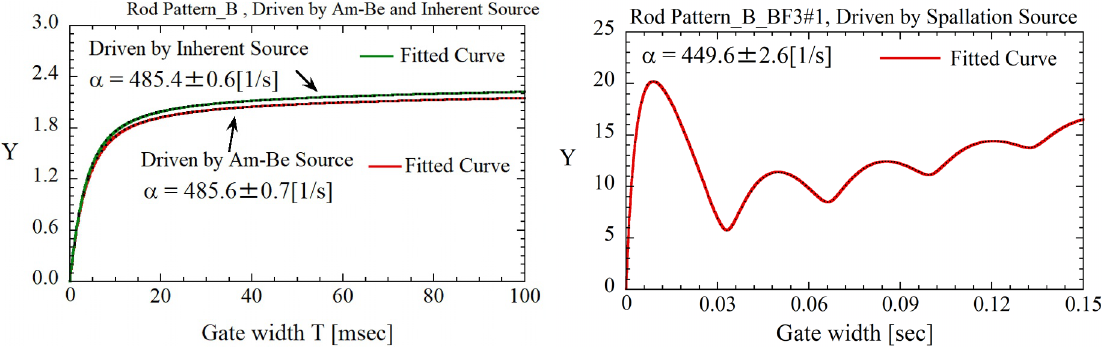
Figure 4. Result of Feynman- α analysis Figure 5. Result of Feynman- α analysis. (Am-Be and Inherent Source). (Spallation